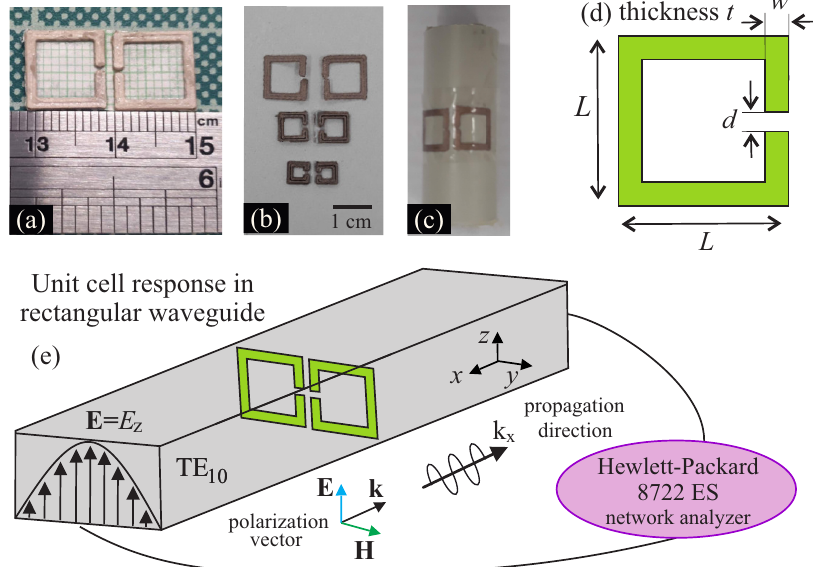
Figure 1. ( a ) Units of PLA coated with conductive Ag epoxy SRRs with opposing gaps attached on the top of a millimeter page. ( b ) SRR configurations of various dimensions made of Electrifi. ( c ) Electrifi SRRs (10 mm) attached to a plastic cylinder of 16 mm diameter. ( d ) Schematic of the SRRs unit and dimensions. ( e ) Characterization set-up; the meta-atoms are placed in the middle of the waveguide and the polarization of the field is along the side of the gaps. The size of the waveguide effectively defines the electromagnetic distance between the unit cells